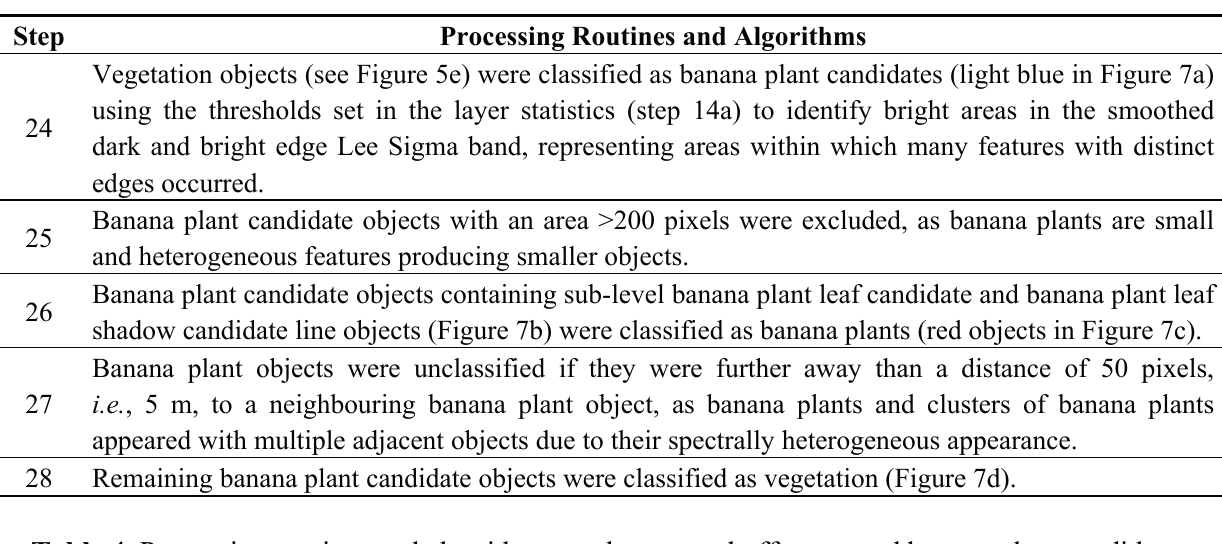
Table 3. Processing routines and algorithms used to extract banana plant candidates.